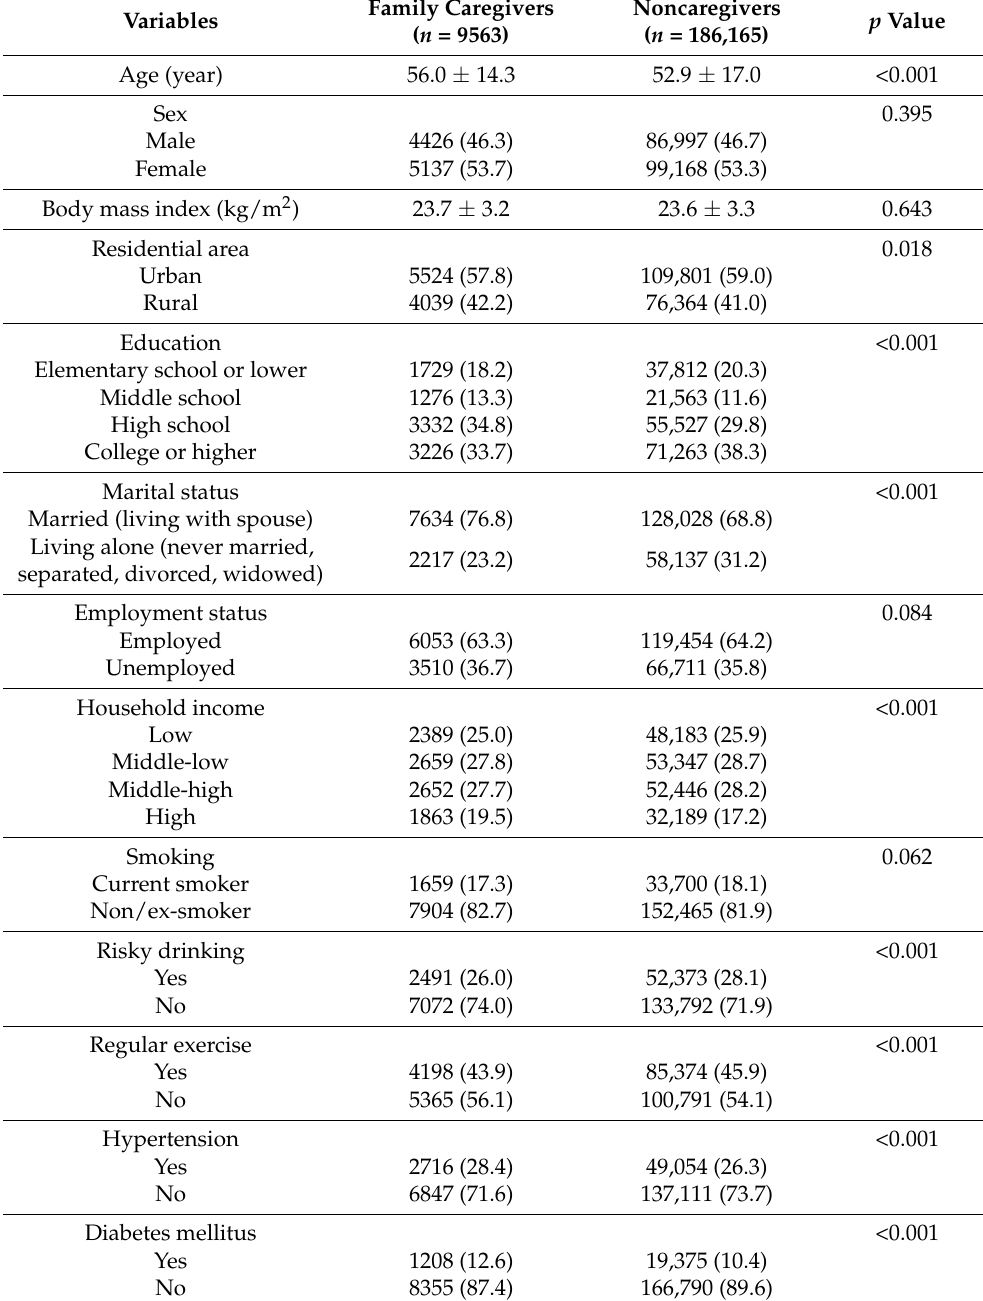
Table 1. Baseline characteristics of the family caregivers of people with dementia and noncaregivers. Family Variables